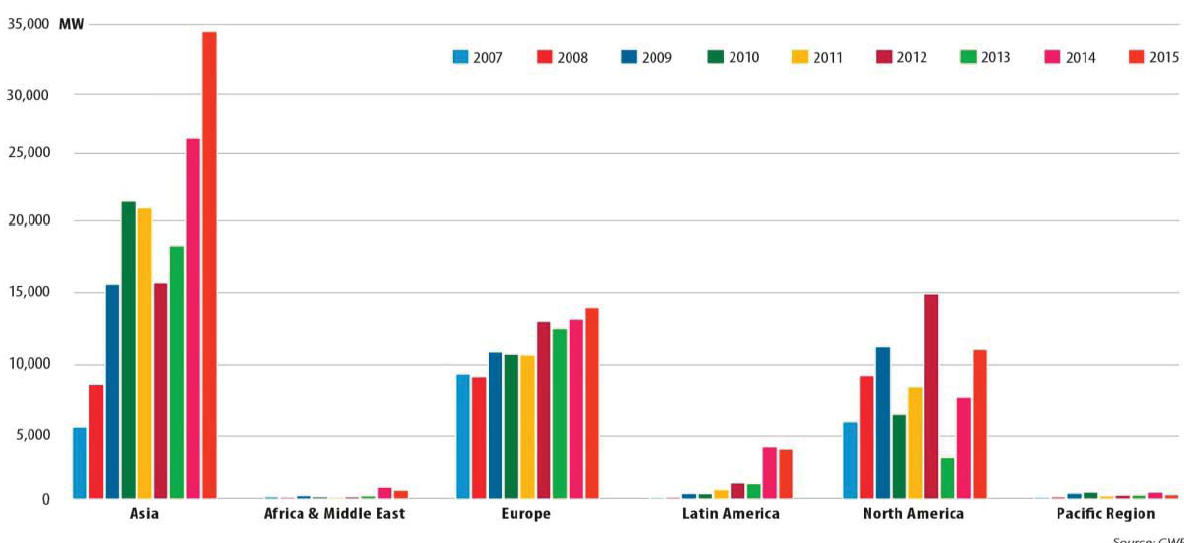
Fig. 1. Annual installed capacity by region